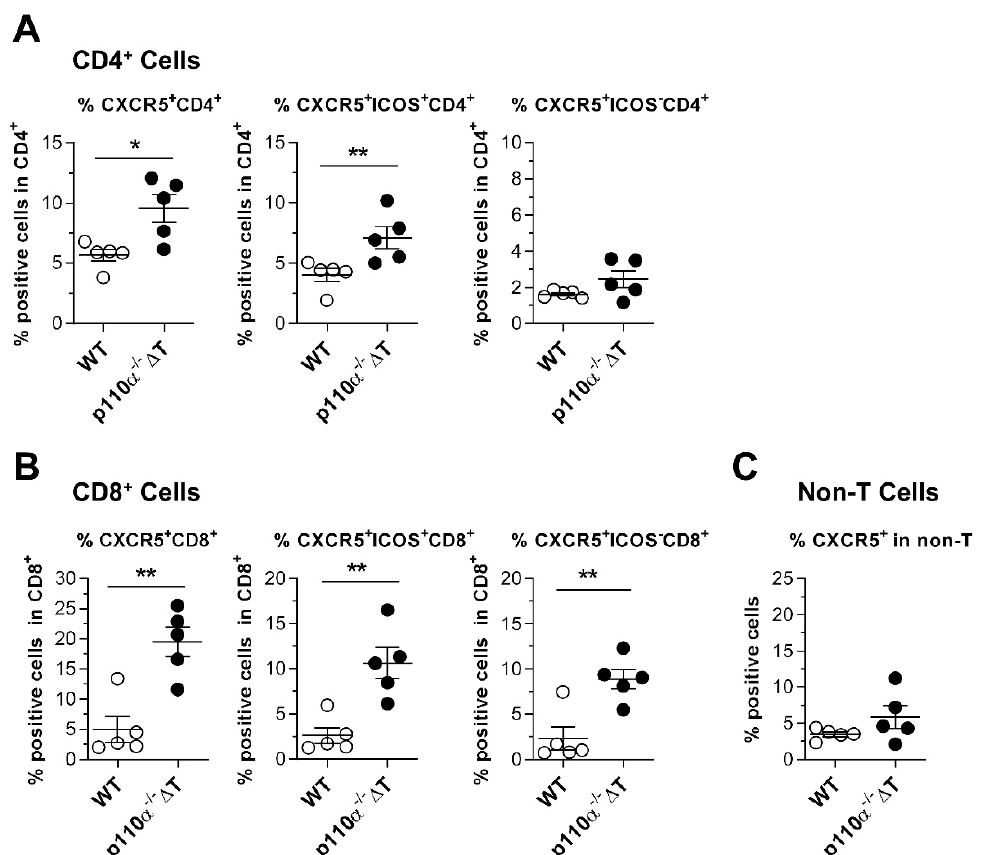
Figure 8. Enhanced expression of the migration regulator CXCR5 in T cells from the draining lymph nodes of p110 α − / − ∆ T mice after 13 days of Collagen-II-immunization. ( A ) Expression of CXCR5 in gated CD4 + T cells, as percentage of CXCR5 + CD4 + T cells (left panel), CXCR5 + ICOS + CD4 + T cells (center panel) or CXCR5 + ICOS − CD4 + T cells (right panel). ( B ) Same as in ( A ), for gated CD8 + T lymphocytes. ( C ) Percentage of CXCR5 + cells in CD4 − CD8 − lymph node cells (non-T cells). Data show the mean ± SEM from individual mice ( n = 5 per group). * p < 0.05; ** p < 0.01.